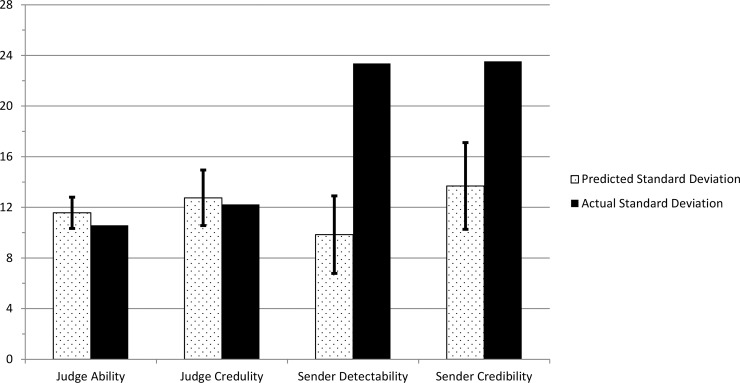
A comparison of the predicted standard deviation from Bond and DePaulo [15] with the actual standard deviations of judge ability, judge credulity, sender detectability and sender credibility in Study 2.Error bars represent the predicted standard deviations within a 95% Confidence Interval.